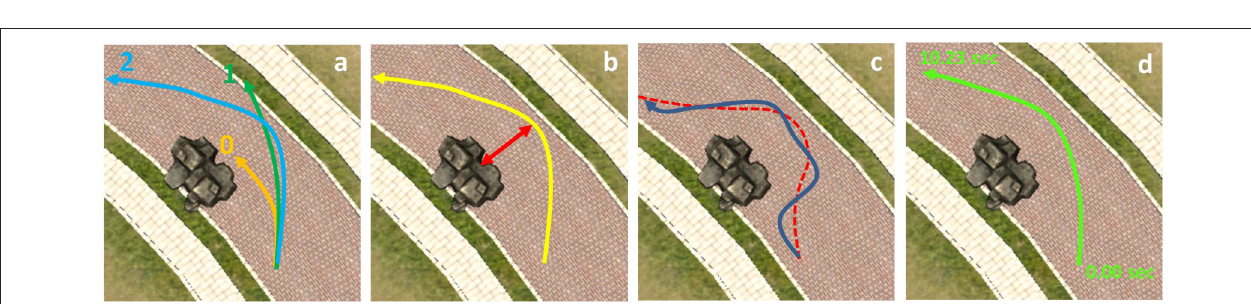
FIGURE 10 | Four metrics to evaluate the subject’s performance: (a) quality of achievement (M1), (b) the minimum distance to an obstacle (M2), (c) mean deviation from a reference trajectory (M3), and (d) the summation of average task completion time (M4).